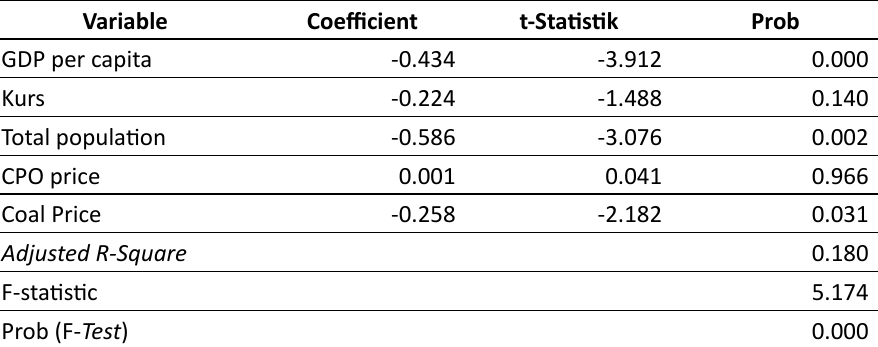
Table 4: Results of Regression Random effect Model